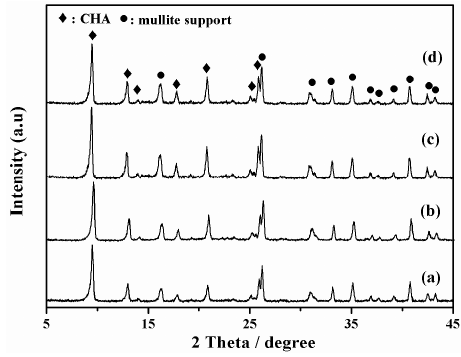
Figure 8. XRD patterns of high silica SSZ-13 zeolite membrane with different synthesis time, ( a ) M-9, 24 h; ( b ) M-10, 36 h; ( c ) M-4, 48 h; ( d ) M-11, 72 h.